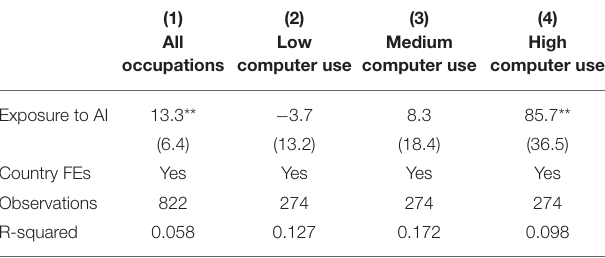
TABLE 2 | Exposure to AI is positively associated with employment growth in occupations where computer use is